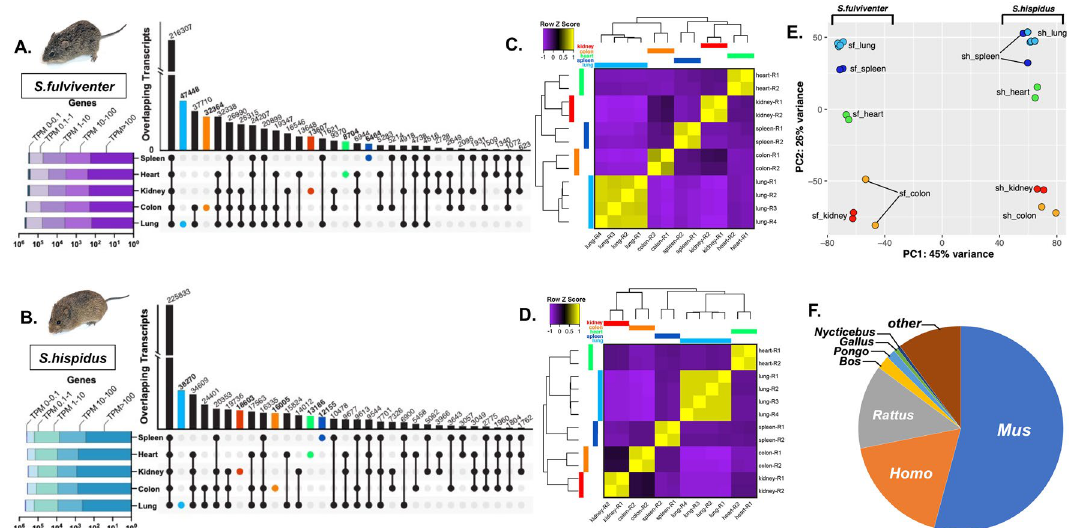
Figure 1. Sigmodon transcriptome assembly using Trinity. ( A , B ) UpSet plot of overlapping and tissue-specific transcripts expressed in the spleen (blue), heart (green), kidney (red), colon (orange), and lung (blue) of both ( A ) S. fulviventer (n = 2) and ( B ) S. hispidus (n = 2) . Bars for overlapping sequences are shown in black, while bars for sequences unique to individual organs are shown in corresponding colors. Number of overlapping transcripts are shown above each bar, with individual organ comparison on the y-axis. Number of unique genes per tissue are represented by the horizontal barplot. ( C , D ) Hierarchical clustering and heatmap by Z-score of all differentially expressed transcripts (Q < 0.001,L2fc > 2, Euclidean distance) within individual tissue samples of both ( C ) S. fulviventer and ( D ) S. hispidus. ( E ) Principal component analysis (PCA) of expressed transcripts within healthy tissue of both species. ( F ) Taxonomic source of gene annotations determined by NCBI BlastX. Data represents annotations of S. fulviventer transcriptome; S. hispidus not shown but varies by ~ 1% in all categories except